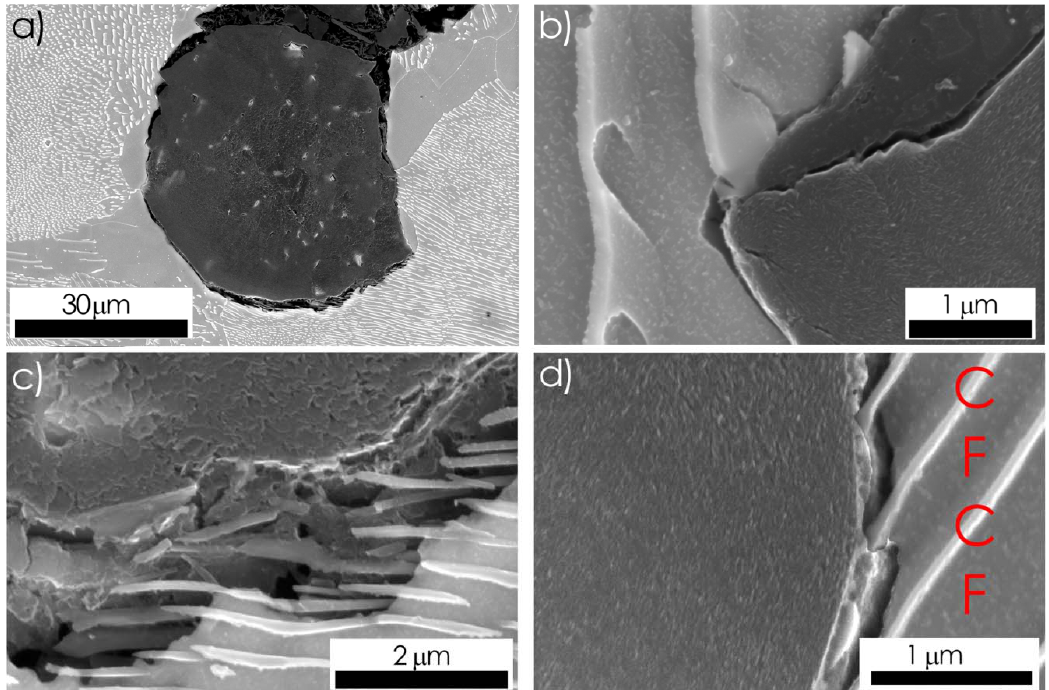
Figure 12. G ‐ M debonding in graphite spheroid in the area near the fracture surface, ADI specimen, SEM: ( a ) General morphology of the G ‐ M interface, and ( b – d ) cementite lamellae blocking partially the G ‐ M debonding, ( b , c ) in pole area, ( d ) in equatorial area (C: Cementite; F: Ferrite).